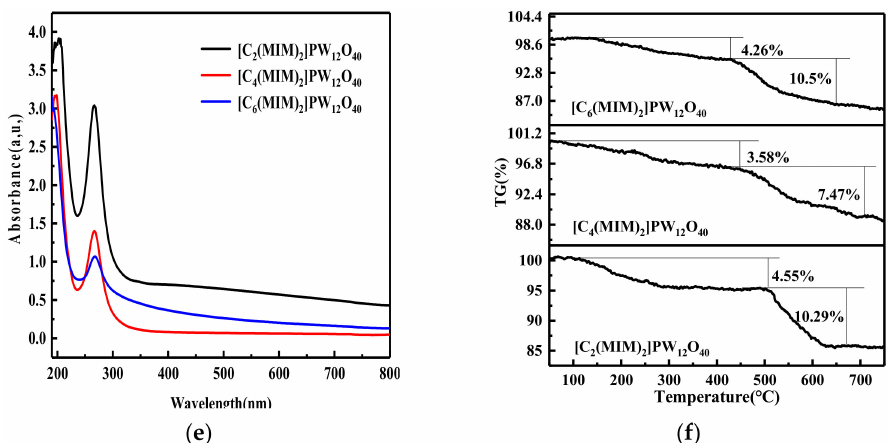
Figure 1. Characterizations of the samples. ( a ) FT-IR spectra of catalysts; ( b ) FT-IR spectra of H 3 PW 12 O 40 ; ( c ) XRD patterns of catalysts; ( d ) XRD patterns of H 3 PW 12 O 40 ; ( e ) Ultraviolet visible (UV-vis) spectra of catalysts; ( f ) Thermogravimetric (TG) curve of